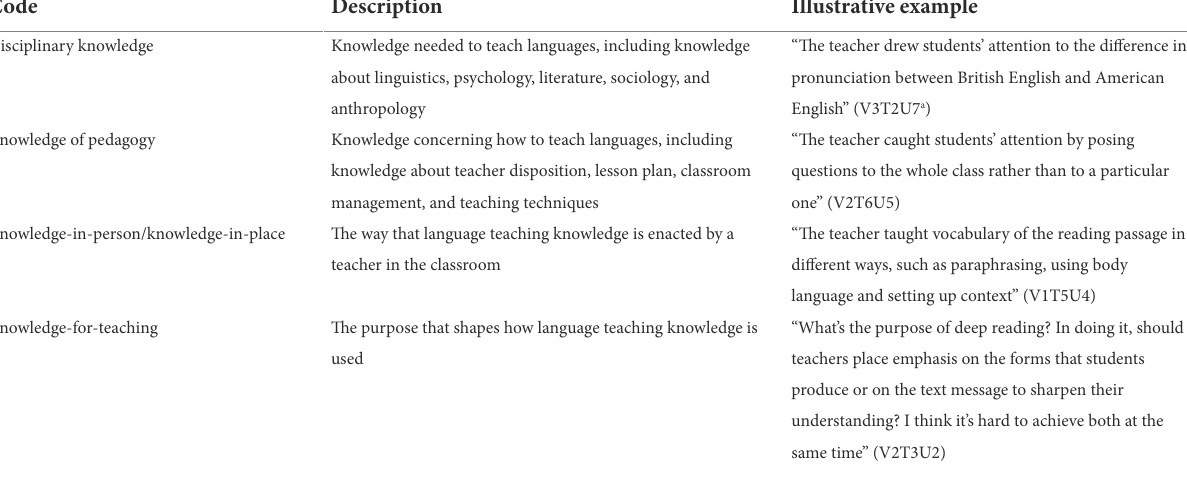
TABLE 2 Codes with descriptions and illustrative examples from the verbal reporting